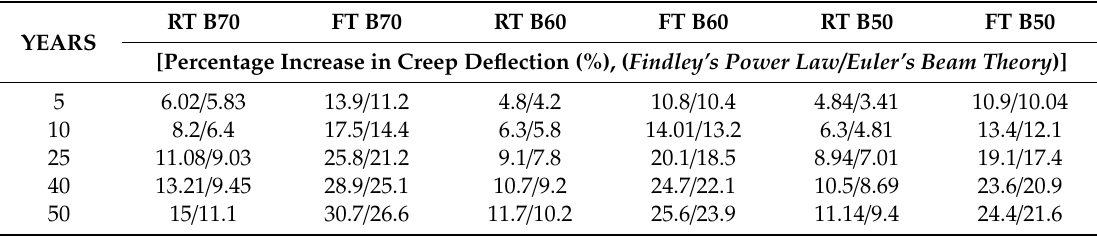
Table 6. Prediction results of time-dependent deflection of RT and FT samples.